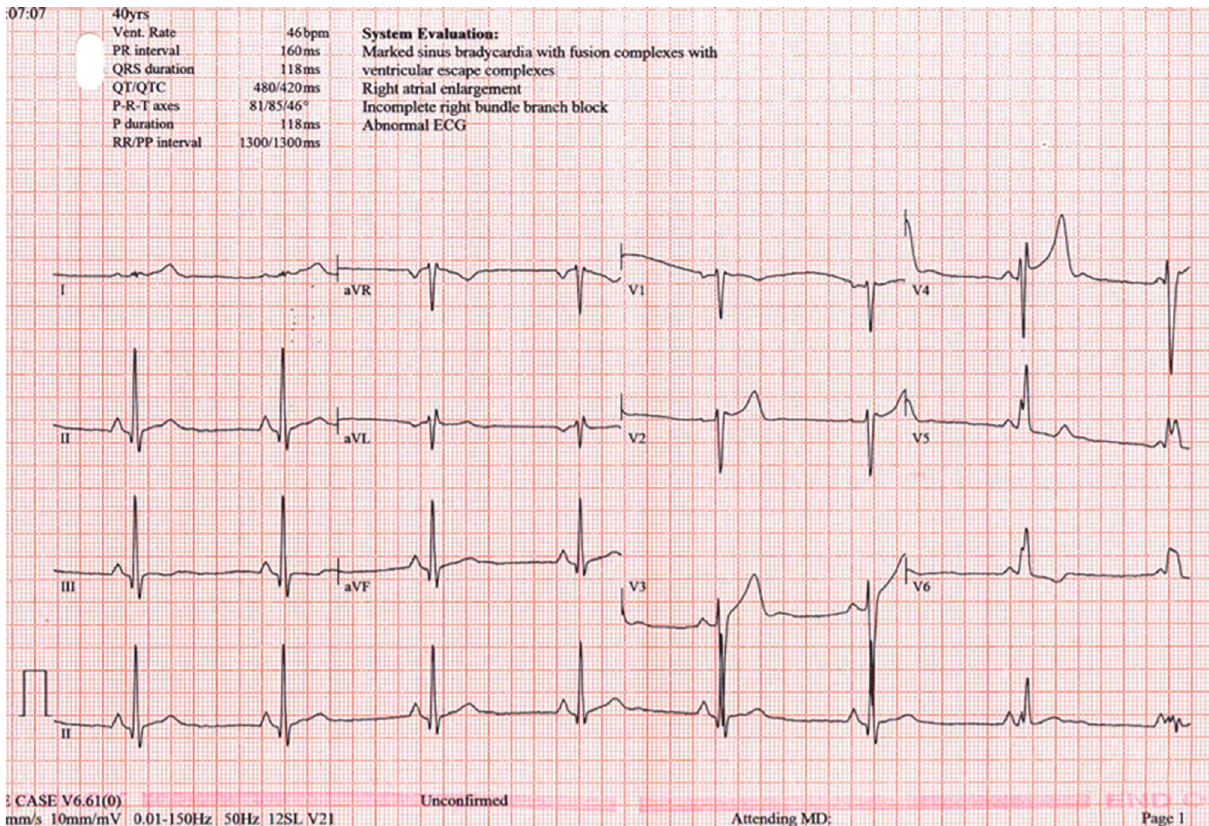
Figure 1: Baseline patient ECG from medical records. Baseline ECG from 2013, with pulse of 46, incomplete RBBB and fusion complexes. We see that our patient had a low resting heart rate in 2013 and has been training for and competing in extreme endurance races such as ultrarunning for the 7 following